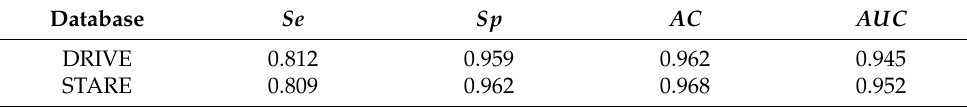
Table 5. Performance on Challenging Images